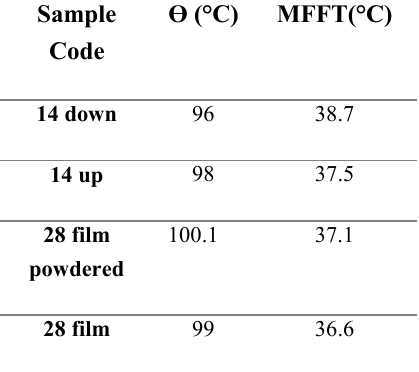
Table 5. MFFT and contact angle